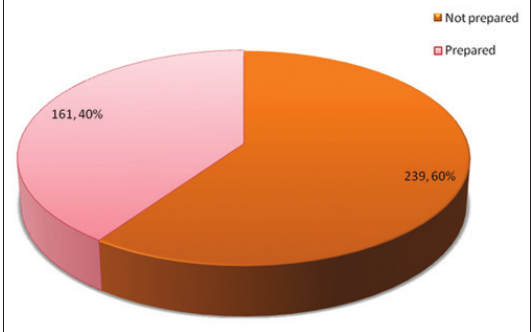
Figure 3 . Birth Preparedness and Complication Readiness among